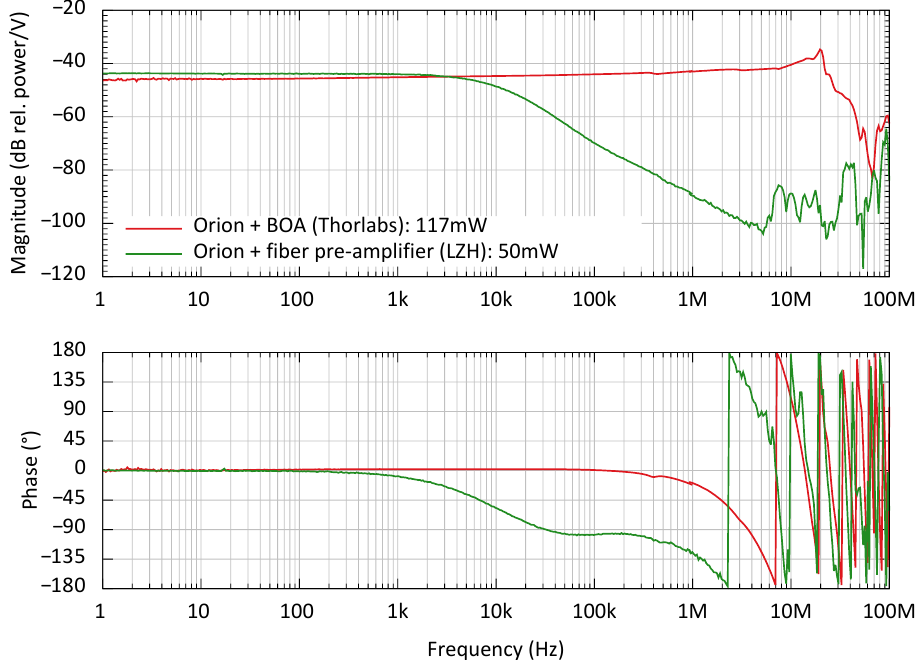
Figure 7. The pump current of the BOA and fiber pre-amplifier’s pump diodes is modulated to measure the transfer function to the pre-amplifier’s output